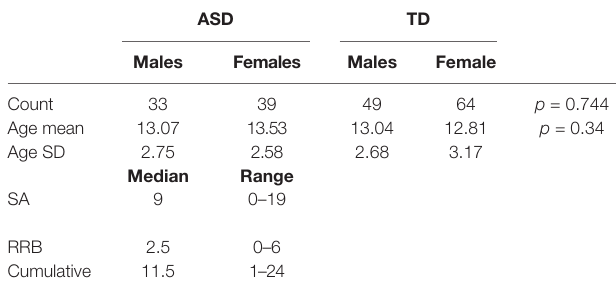
TABLE 1 | The used cohort summary statistics.